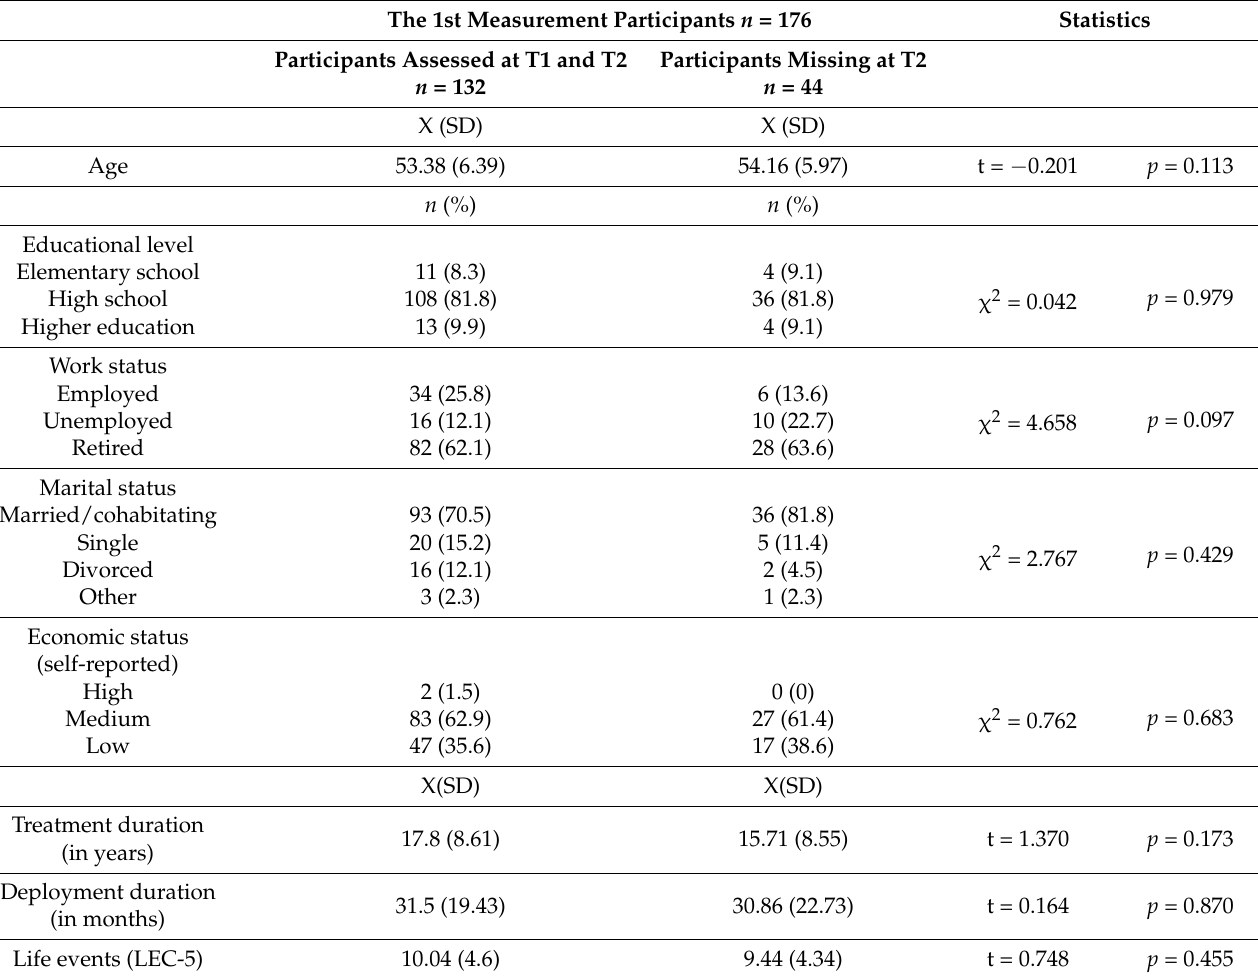
Table 1. Sociodemographic characteristics of study participants at the first assessment (T1). Data are presented as count (percentage) unless otherwise